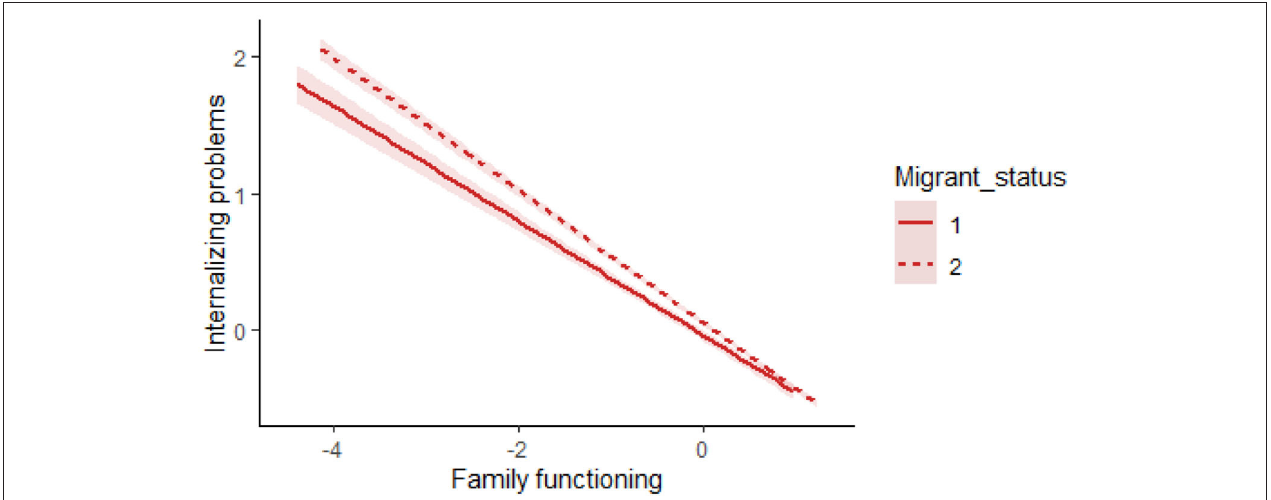
FIGURE 2 | The moderating role of migrant status in the relationship between family functioning and internalizing problems. The solid line (migrant status is 1) indicates the group of migrant adolescents; the dotted line (migrant status is 2) indicates the group of local-born adolescents. The shadowed areas represent standard errors.